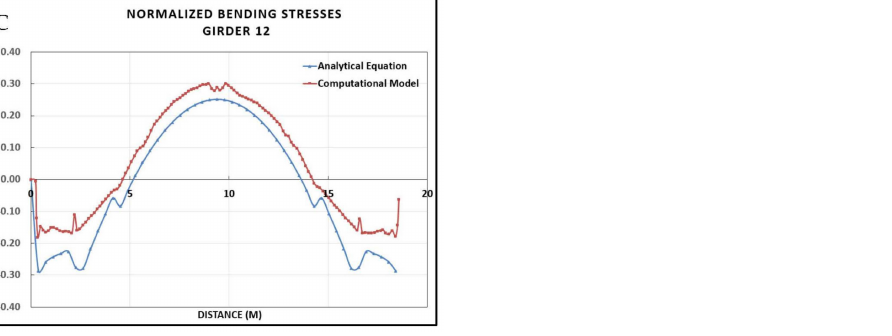
Figure 10. Three charts showing agreement in numerical and analytical solutions for the L&D No. 27. ( A ) Girder 3 near the top of the gate, ( B ) Girder 8 near the middle, ( C ) Girder 12 at the bottom.